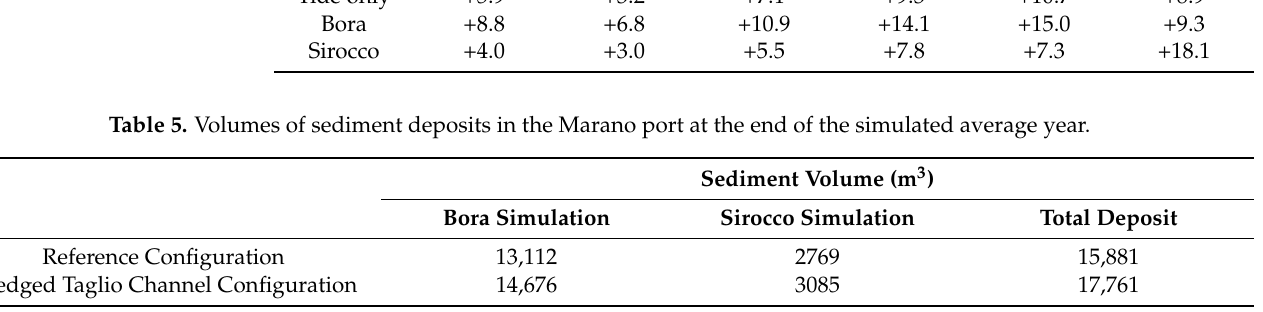
Table 4. Simulations with a dredged Taglio channel. Flow variations with regard to the correspond- ing simulation on the reference configuration.